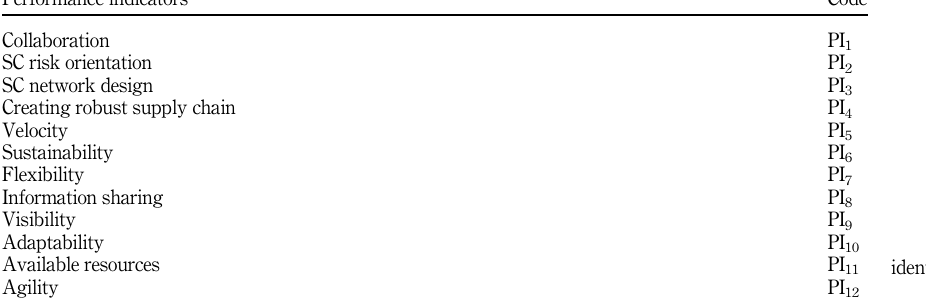
Table 3. The list of PIs identified through the Delphi